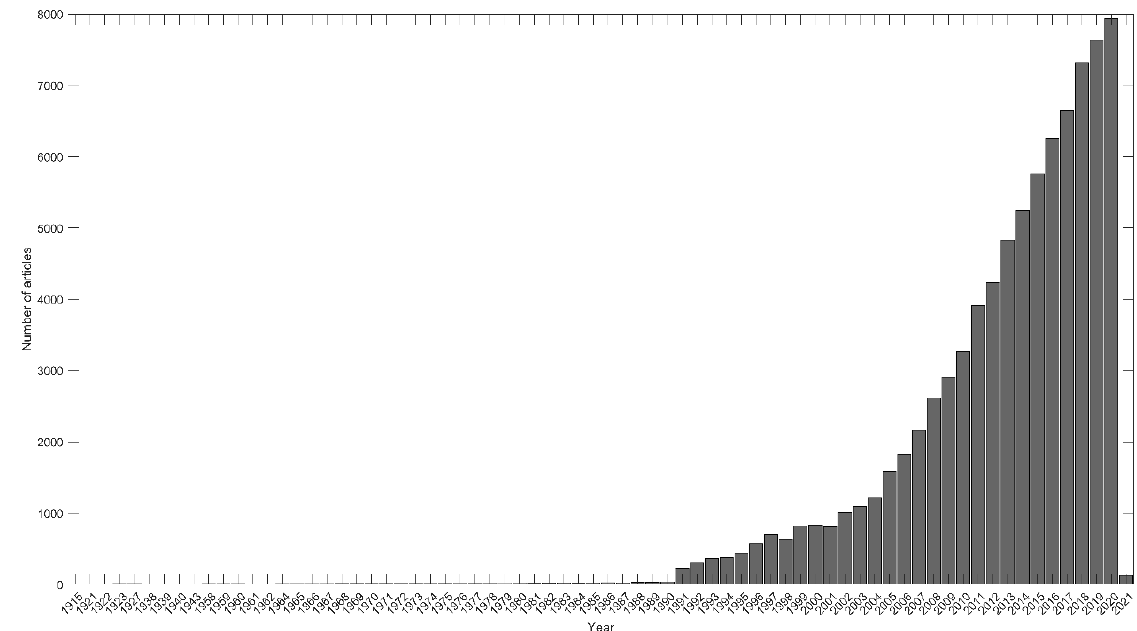
Figure 2. Increase in scientific production in the WOS on the subject of physical exercise in school-age youth and vulnerable populations.